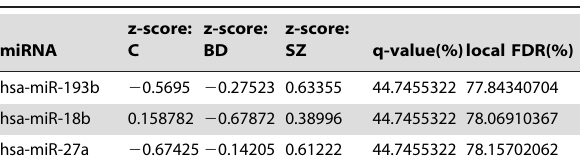
The list of 198 miRNAs were narrowed from 312 microRNA using a linear regression model and subsequently ranked by z-score test statistics. Local FDR evaluates false discoveries by assigning samples to random groups to test for statistical significance by chance. The relevance of FDR is determined using q- values, an analog of the p-value. The 21 top-ranked miRNAs have a q-value equal to 0%, meaning that it is highly unlikely for this miRNAs to be expressed differentially by chance among the three groups examined. SZ= schizophrenia; BD= bipolar disorder; C=